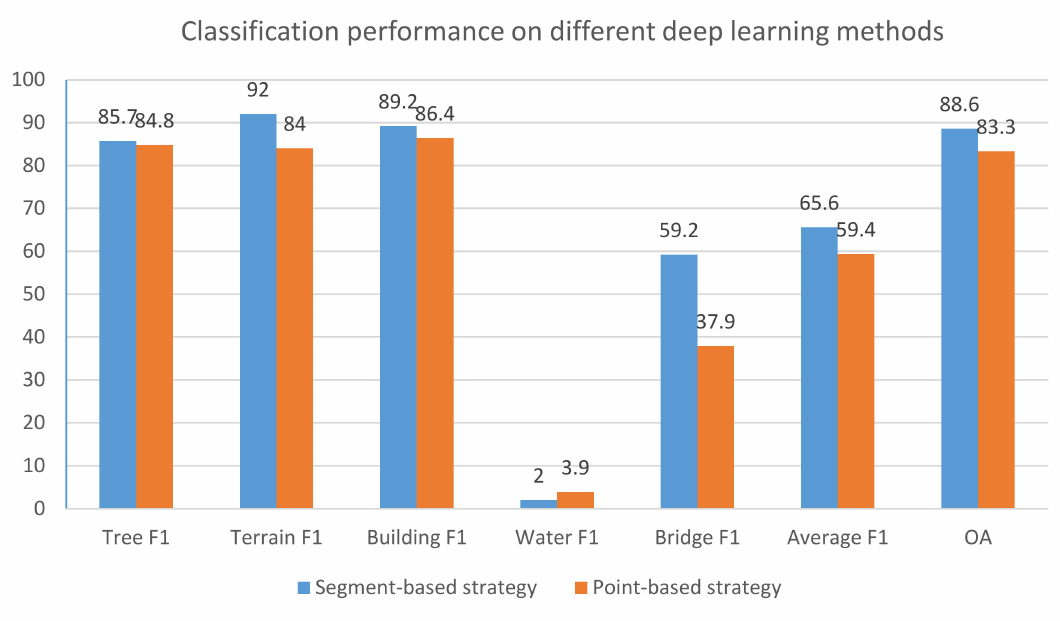
Figure 8. Comparison between segment-based strategy and point-based strategy in the testing area using initial point-in-polygon training